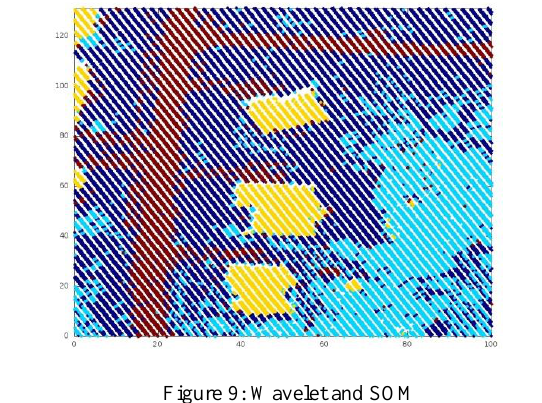
Figure 9: Wavelet and SOM